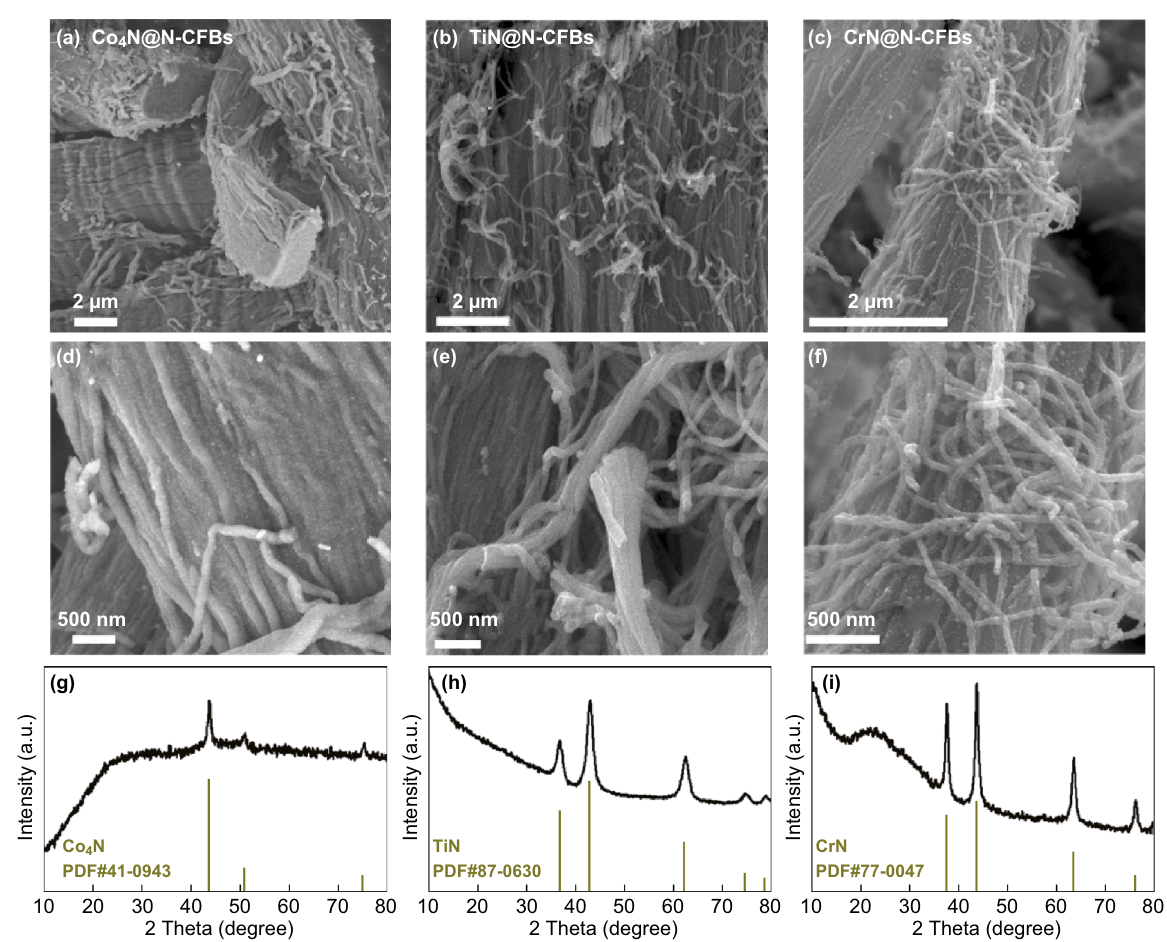
Fig. 3 FESEM images of a , d Co 4 N@N-CFBs, b , e TiN@N-CFBs, and c , f CrN@N-CFBs prepared using SCFs as templates and g – i corre- sponding XRD